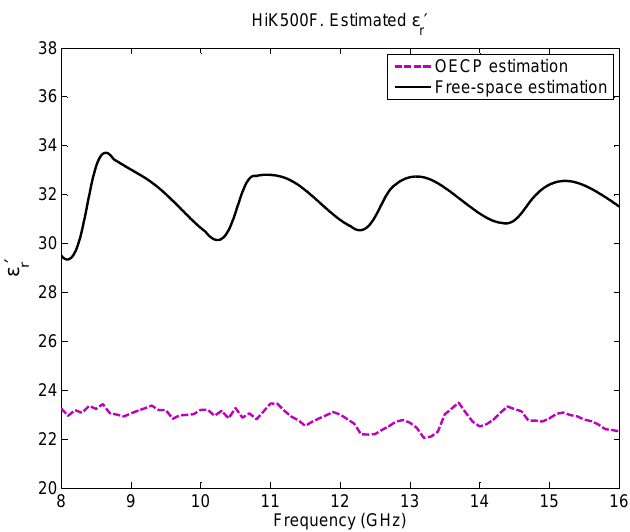
Figure 7. Eccostock HiK500F estimated permittivity: (cid:101) (cid:48) r . Table 3. Eccostock HiK500F. Extracted mean permittivity (f = 8–16 GHz) for OECP and free-space.